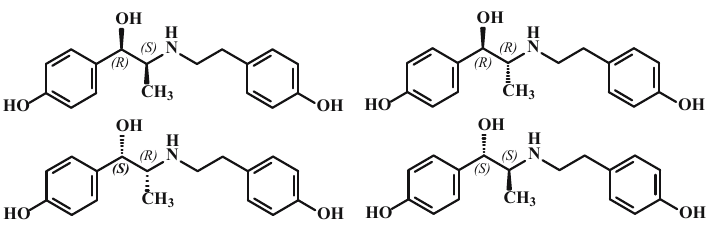
Figure 2: Chemical structures of ritodrine stereoisomers.